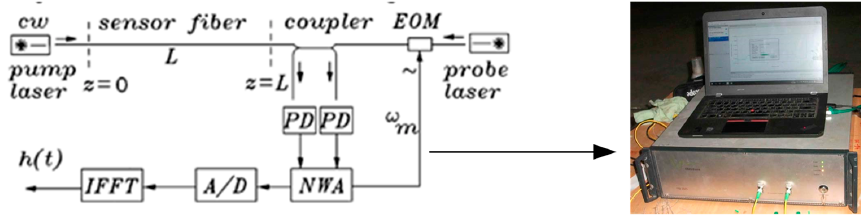
Figure 3. Basic configuration of a BOFDA sensor.